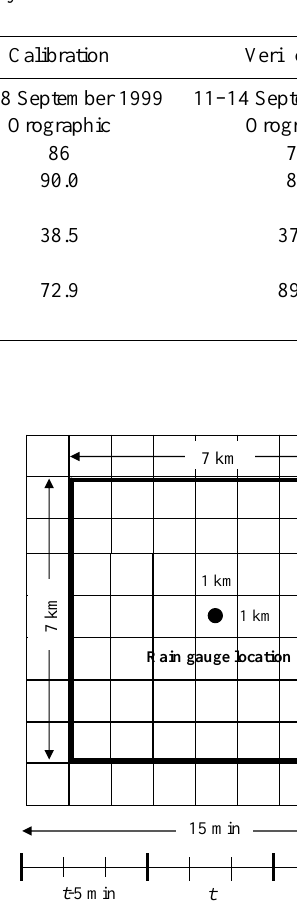
Table 1. Characteristics of rainfall observed at 13 rain gauges in the study watershed.